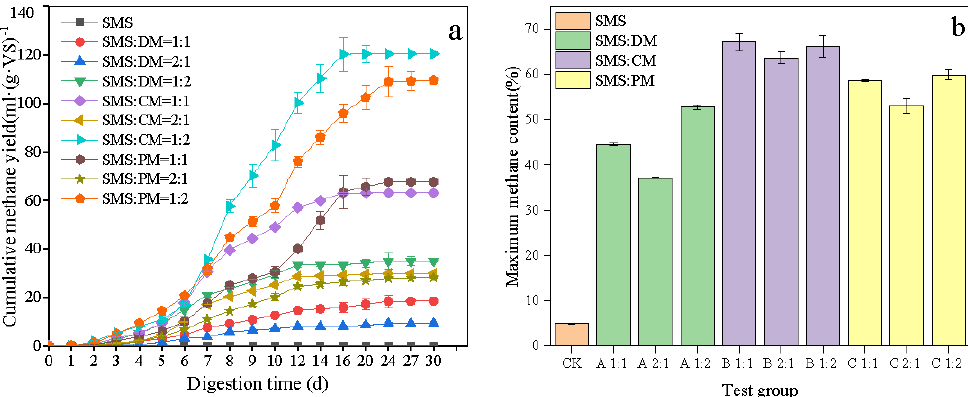
Figure 2. The cumulative methane production ( a ) and the maximum methane content ( b ) of co- digestion of SMS and different livestock manure.